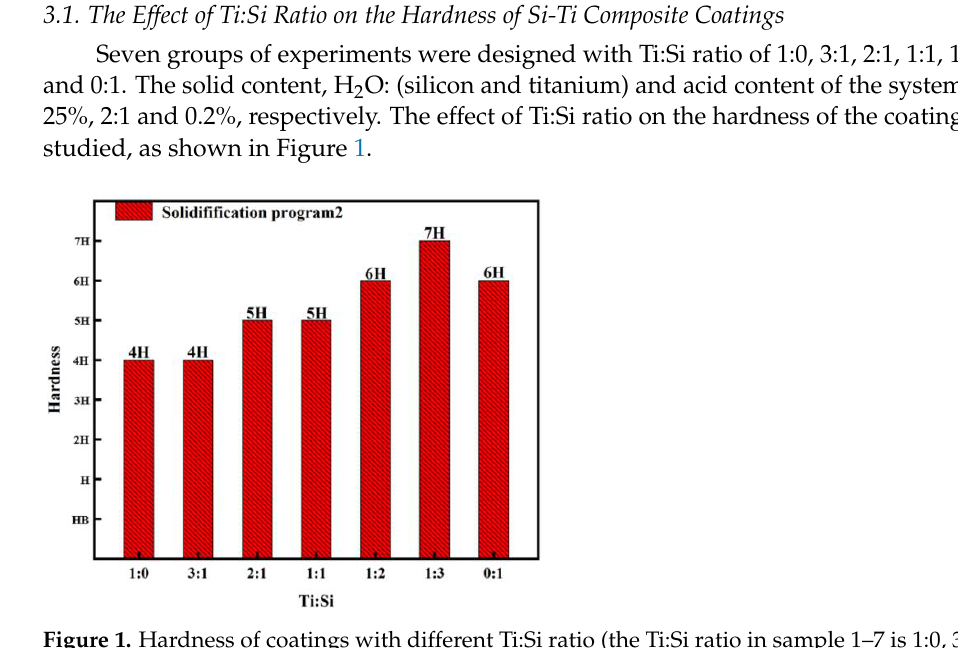
Figure 1. Hardness of coatings with different Ti:Si ratio (the Ti:Si ratio in sample 1–7 is 1:0, 3:1, 2:1, 1:1, 1:2, 1:3, 0:1).